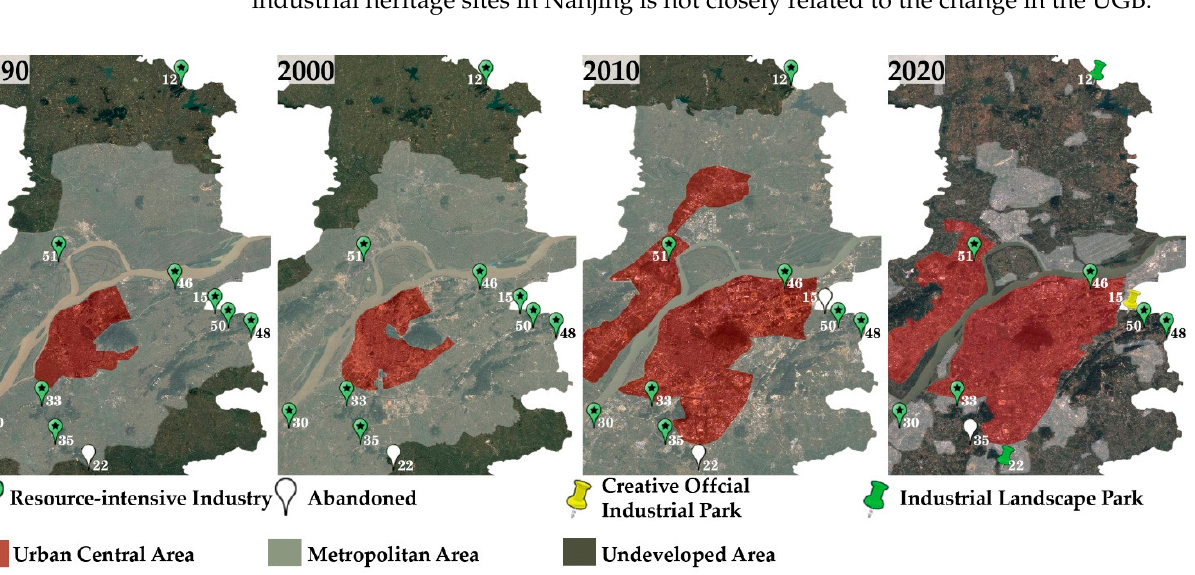
Figure 26. The change in the relationship between the operation state of resource-intensive industries and urban growth boundary over time (Figure source: own drawing; data source: on-site investigation and interview).